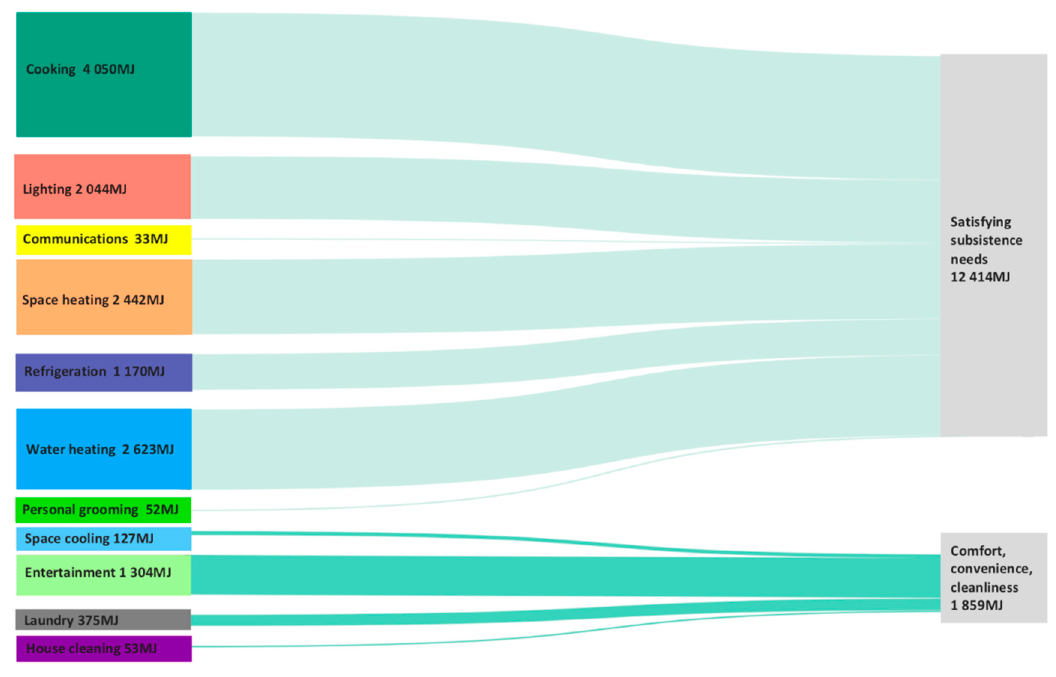
Figure 9. Energy drivers for low-income households. Source: Strydom et al. [58].